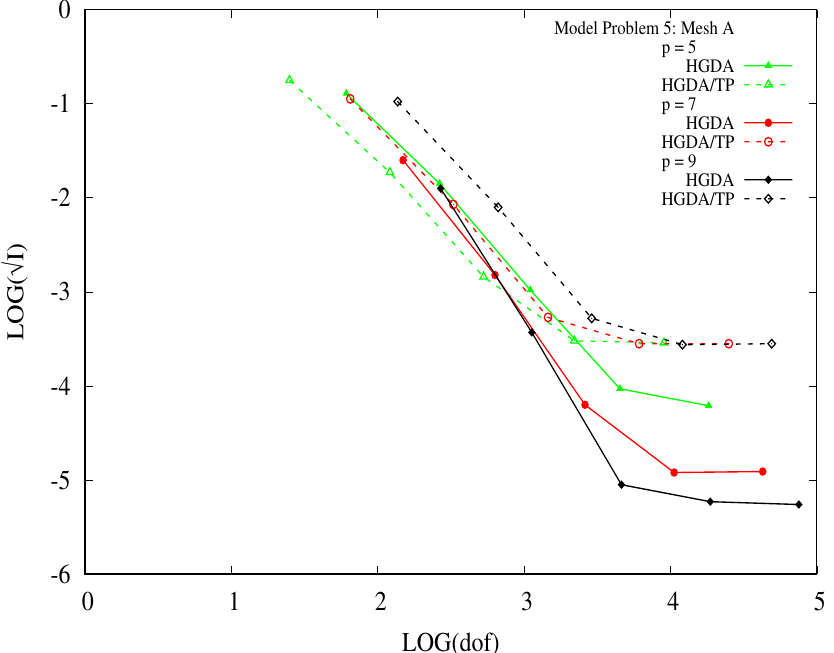
Figure 23. Residual function I versus dof, C 22 solutions: Model Problem 5 (Convection Diffusion Equation; Mesh A; HGDA/DG and